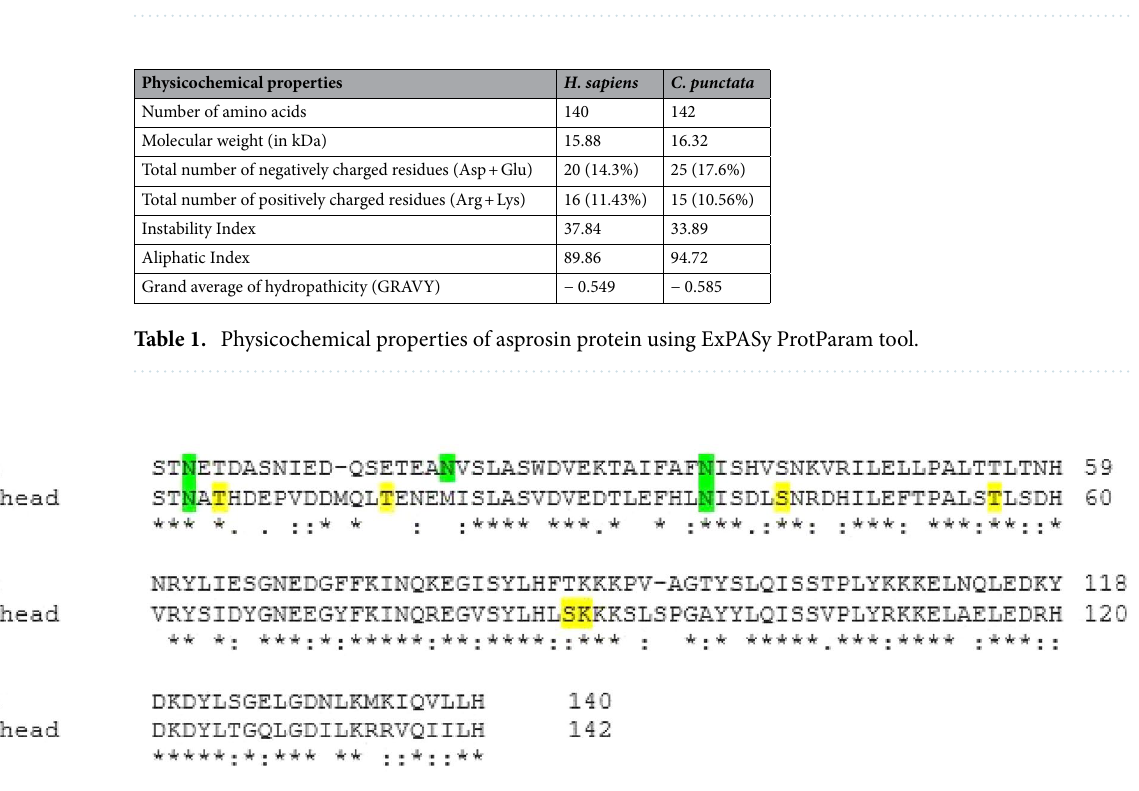
Figure 3. Expression analysis of recombinant ss asprosin. ( a ) 15% SDS-PAGE showing the protein expression in the uninduced pellet, induced pellet, uninduced supernatant and induced supernatant samples observed using coomassie staining. ( b ) Western blotting using anti-His antibody for validation of recombinant asprosin in supernatant of induced and uninduced samples.